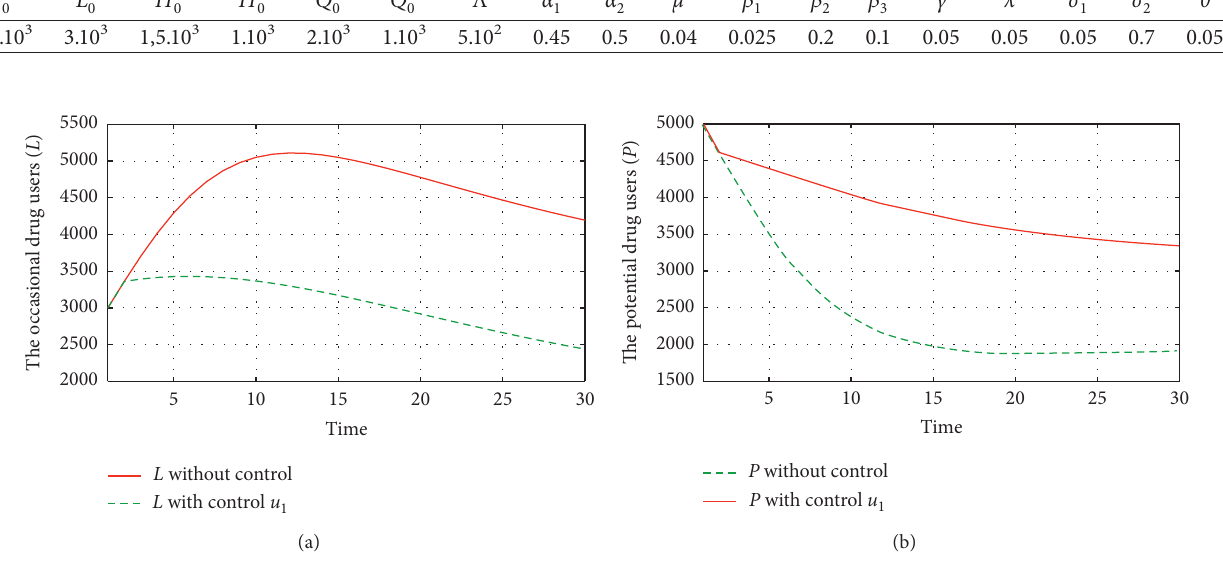
Figure 2: (a) The evolution of the L with and without controls. (b) The evolution of the P with and without